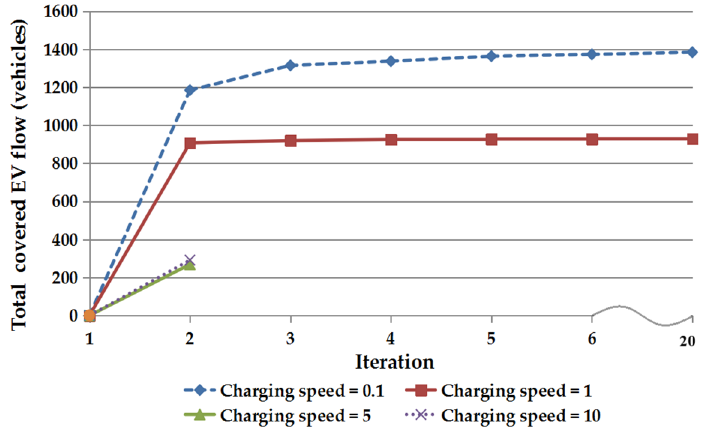
Figure 6. The sensitivity analysis of charging speed.